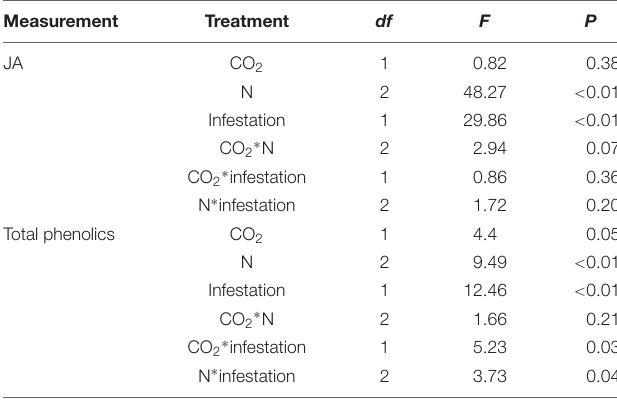
TABLE 3 | Summary of ANOVA results for effects of elevated CO 2 and increased nitrogen fertilization on chemical defenses of maize. Measurement